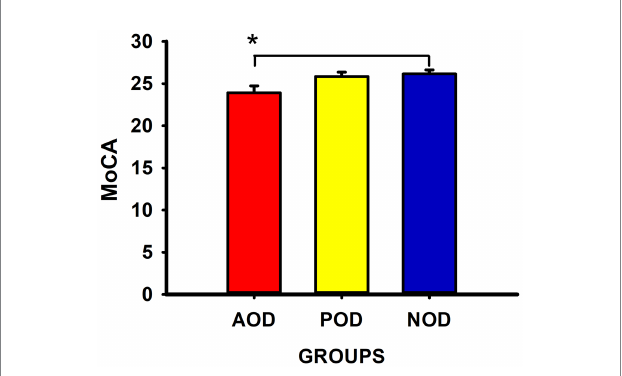
FIGURE 1 Montreal Cognitive Assessment (MoCA) scores (Mean ± SEM) in the groups. AOD group = acute olfactory dysfunction; POD group = persistent olfactory dysfunction; NOD group = absence of olfactory dysfunction. *statistically significant, p <